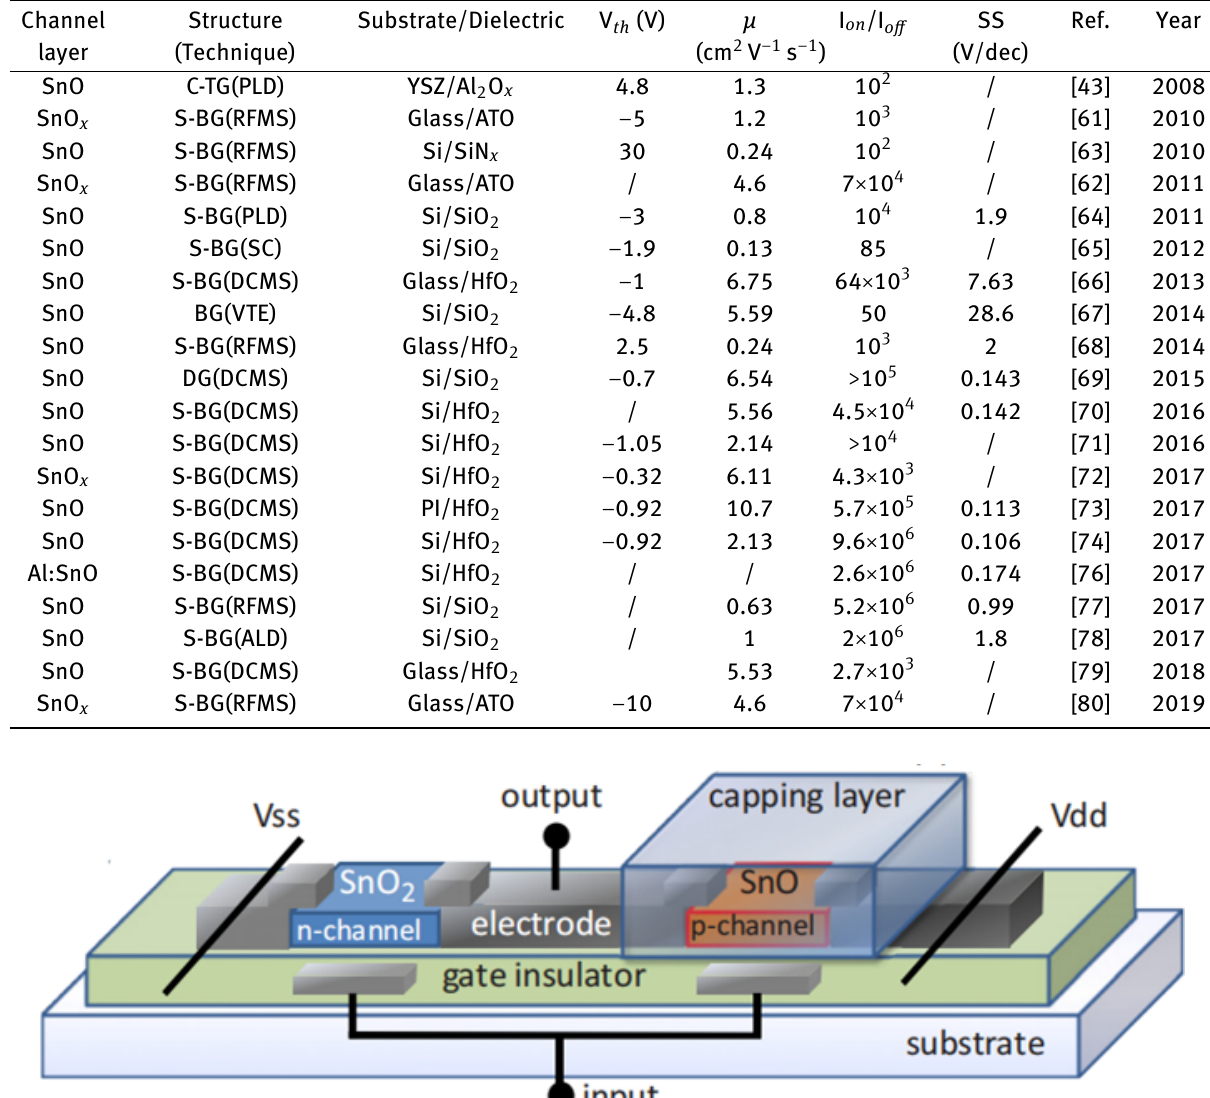
Table 2: Short-review of the reported p-type tin oxide TFTs